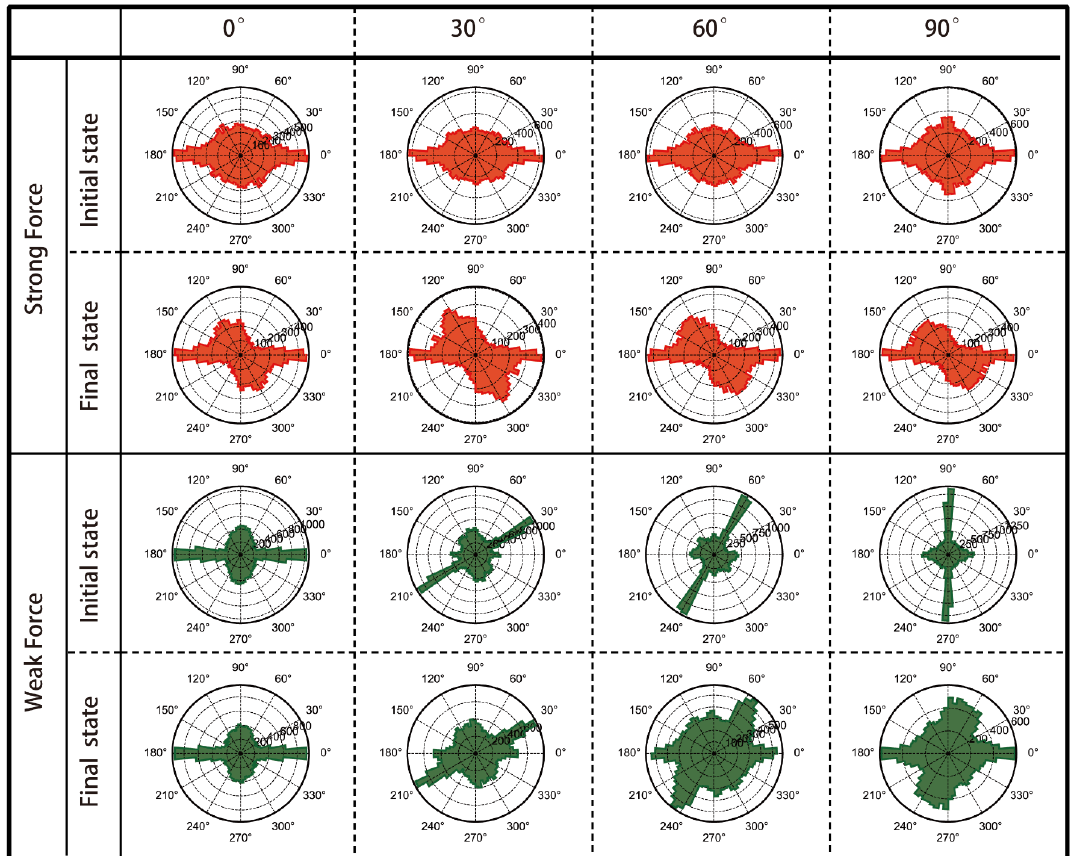
Figure 9. Polar distributions of contact normals for strong and weak contacts before and after shearing in the xz plane.